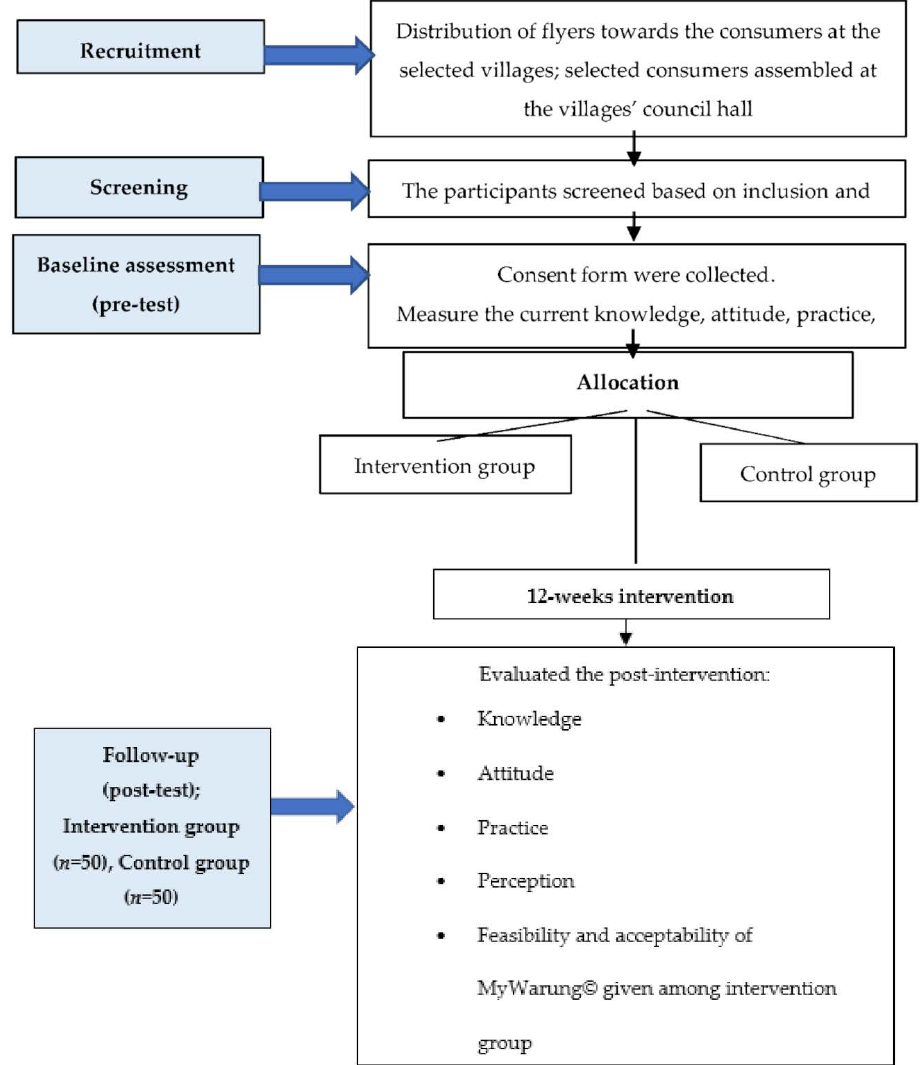
Figure 4. Flow diagram of the